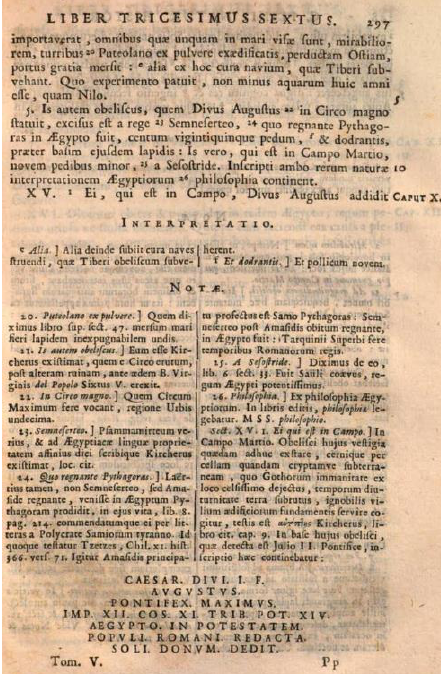
Figure 4: Caii Plinii secundi Naturalis historiae, Liber Tricesimus Sextus, Caput X, S